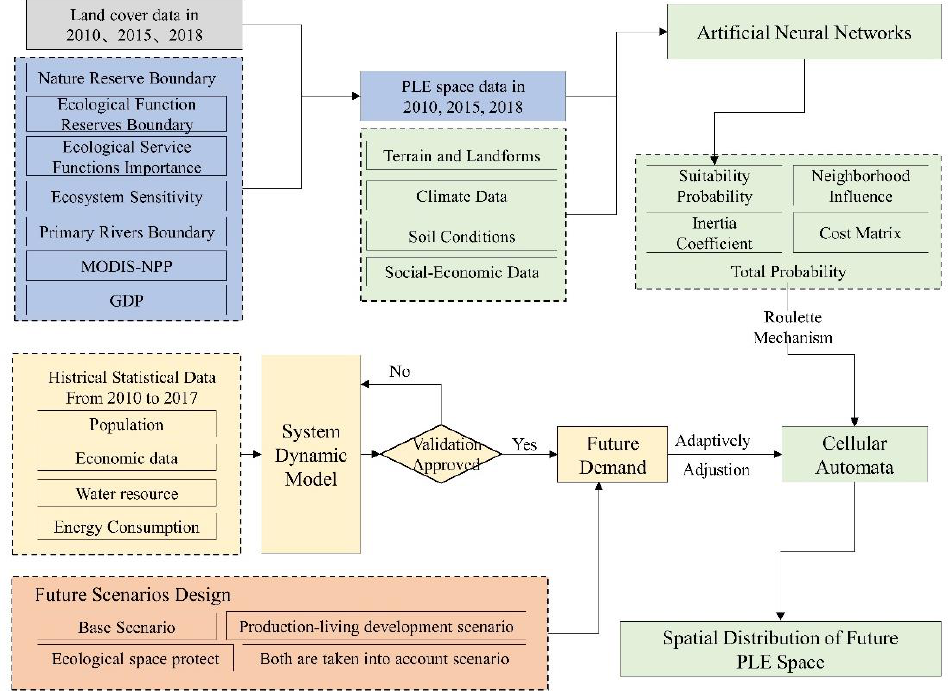
Figure 3. Workflow for the optimization.